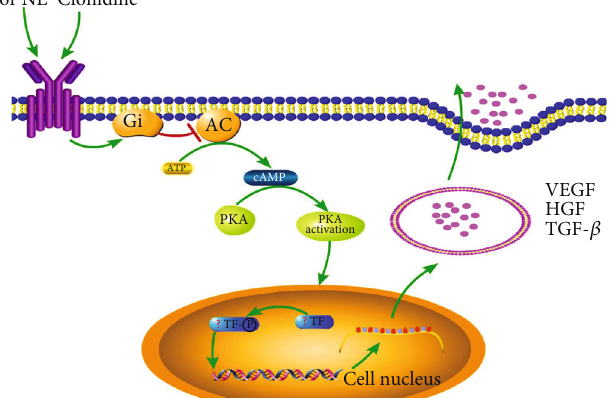
Figure 7: Regulation of growth factor exocytosis by Adra2a. Activation of these receptors by epinephrine (E), norepinephrine (NE), and clonidine in ASCs results in receptor-Gi coupling that inhibits adenyl cyclase (AC). This inhibition, in turn, results in decreased conversion of ATP to cAMP and reduced protein kinase A (PKA) activity; this may increase the activation of some transcription factor- (TF-) mediated mRNA expression of growth factors and then decline the exocytosis of the growth factors in